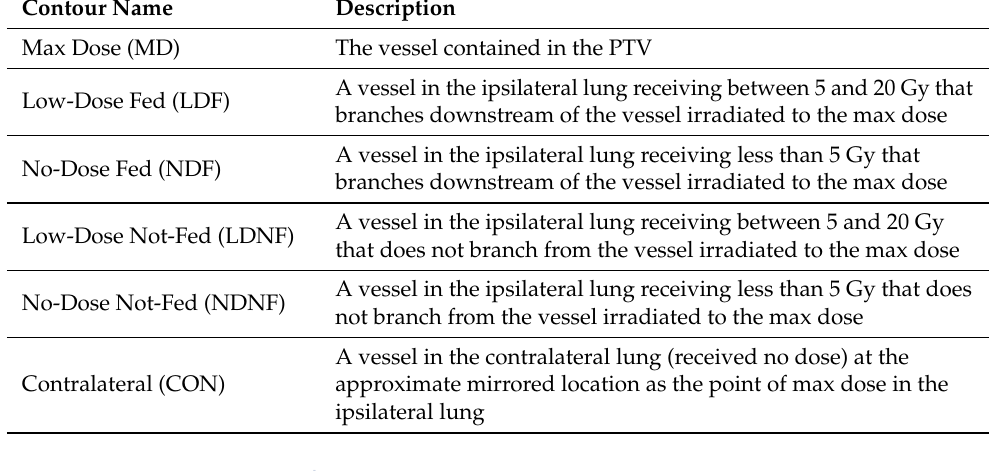
Table 1. Description of contours analyzed on each subject.